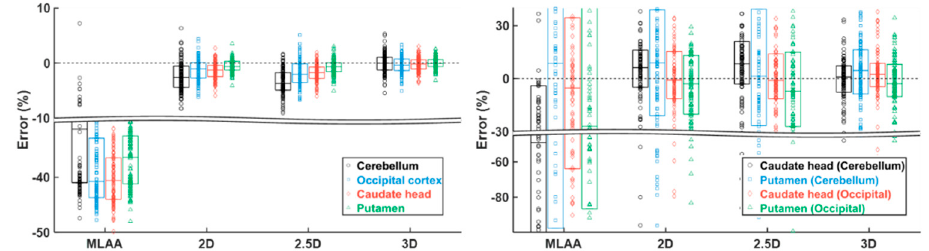
Figure 6. Regional standard uptake value (SUV) (left) and standard uptake value ratio (SUVr) (right) errors. The boxes indicate standard deviation, and the horizontal black bands are where the y -axis is broken at different